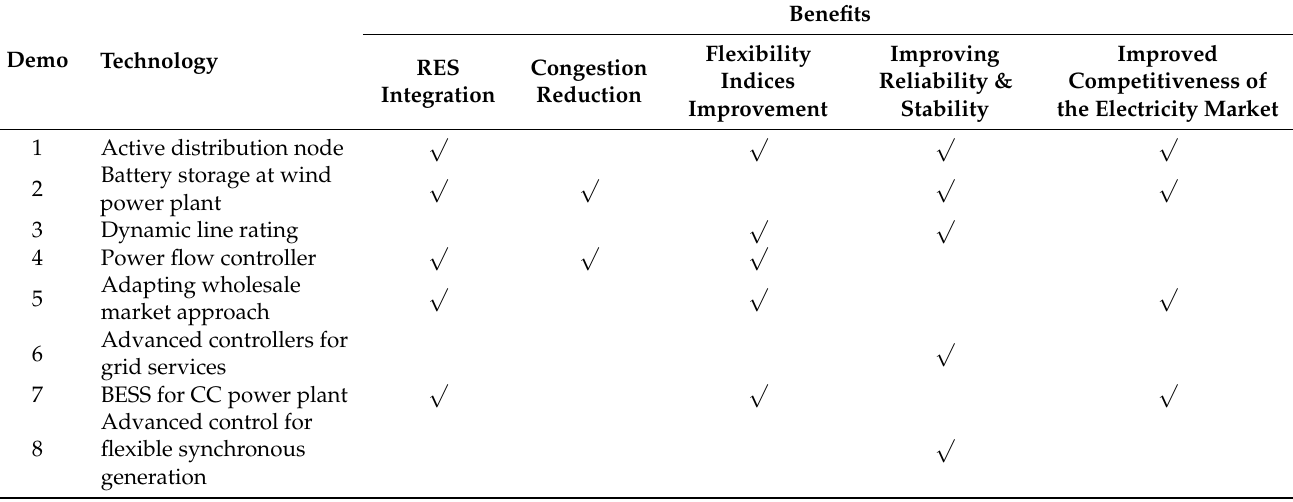
Table 2. Mapping of system benefits with different demonstration and tested technologies of